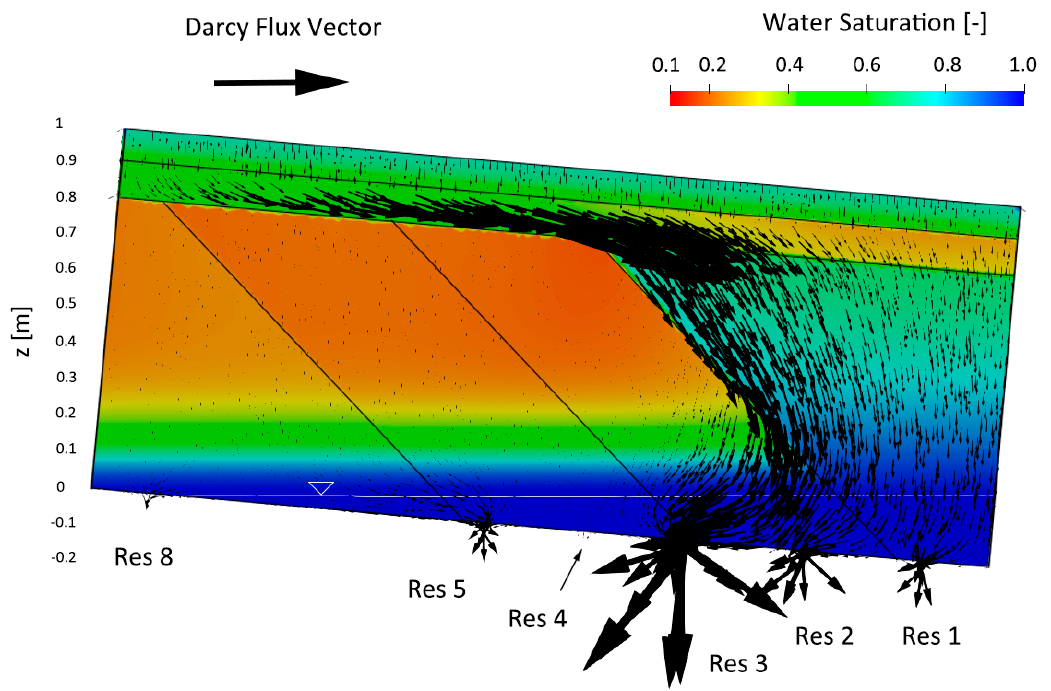
Figure 4. Simulated results of the calibrated flow model. The black arrows represent the Darcy flux vectors simulated by the numerical model indicating the direction of the fluid flow pathways and their relative magnitude, overlain on the simulated water saturations throughout the cross section of the experiment. The left bottom corner was set to z = 0 cm; the simulated water table is shown in white.